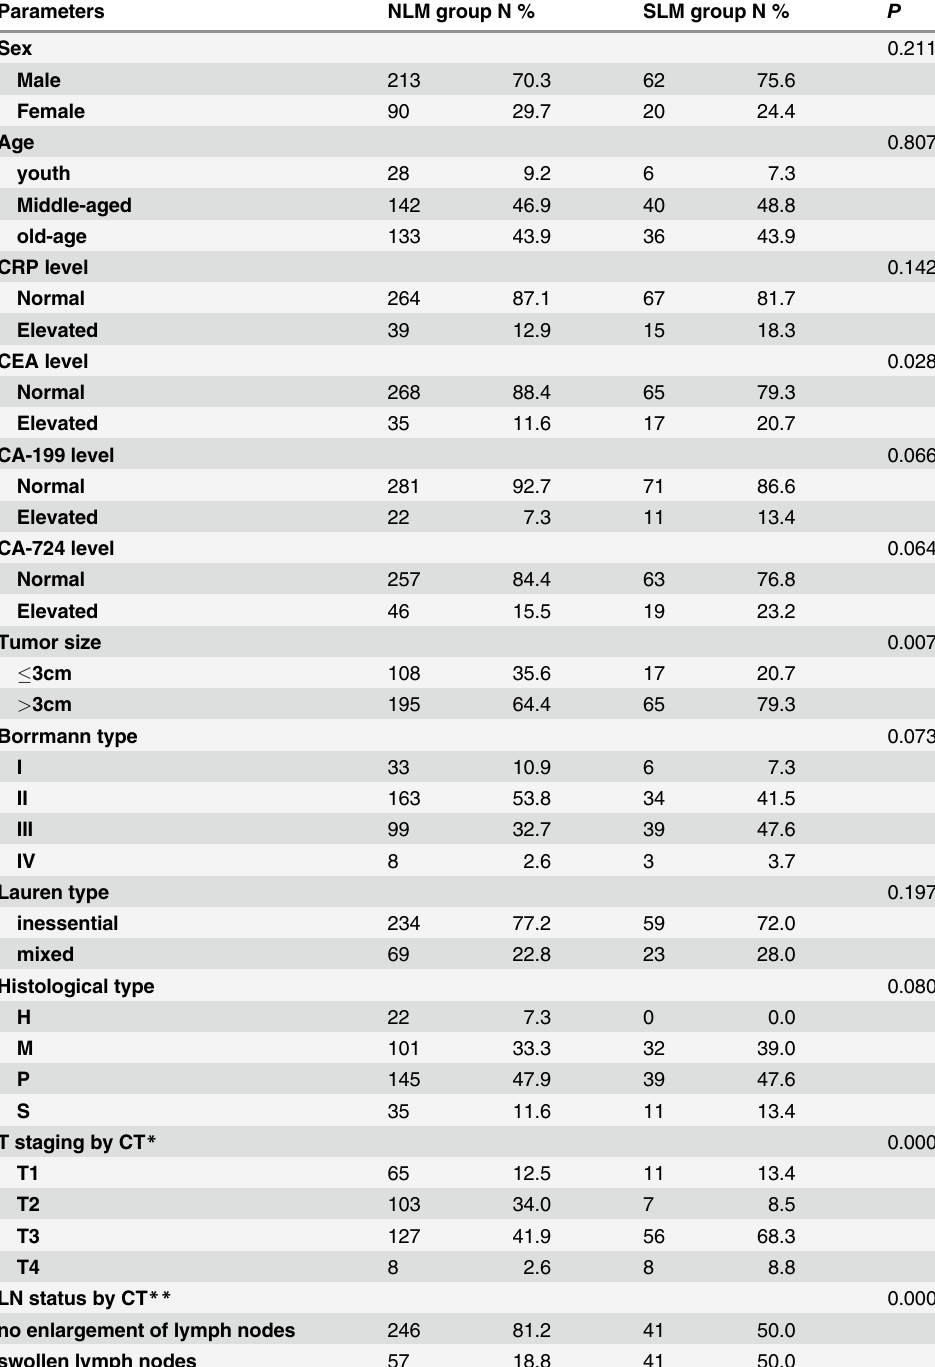
Table 1. The clinicopathologic features between NLM group and SLM